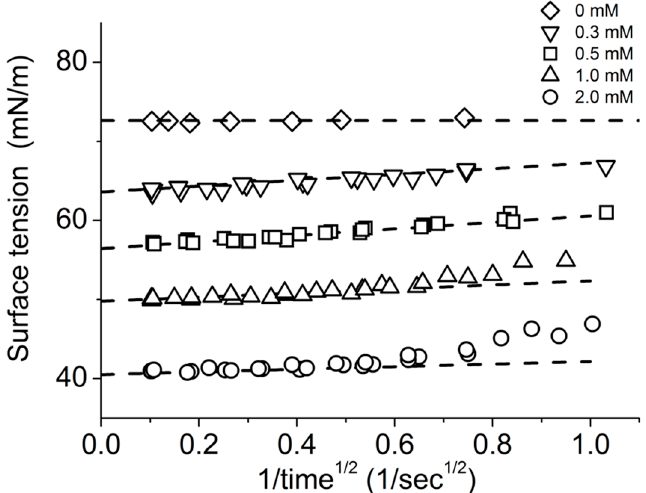
Figure 16. 1 ‐ Octanol dynamic surface tension at 20 °C plotted according to the Ward – Tordai long ‐ time approximation model Equation (7). 1 ‐ Octanol surface tensions from Figure 14b are plotted as a function of t − 1/2 . The dashed lines show the best fitting line at each concentration. With permission from Elsevier [7].